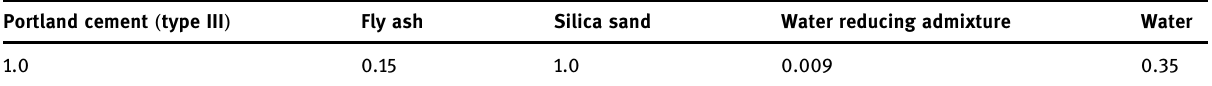
Portland cement ( type III